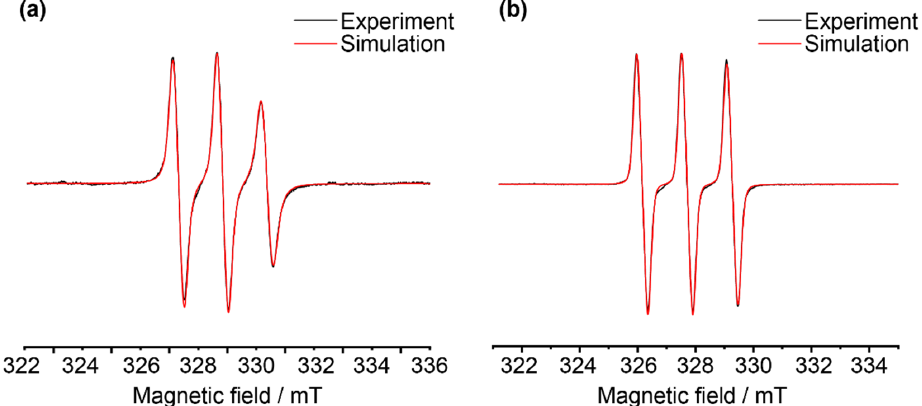
Figure 2. Electron paramagnetic resonance (EPR) spectra and appropriate simulations of ( a ) 0.1 mM sRL2 (molar ratio of spin label 1 to RL2 2 : 3.5) in an aqueous solution, pH 5.5; ( b ) 0.2 mM radical 2 in 50 mM phosphate-buffered saline (PBS), pH 7.2. The spectra were acquired at 35 ◦ C